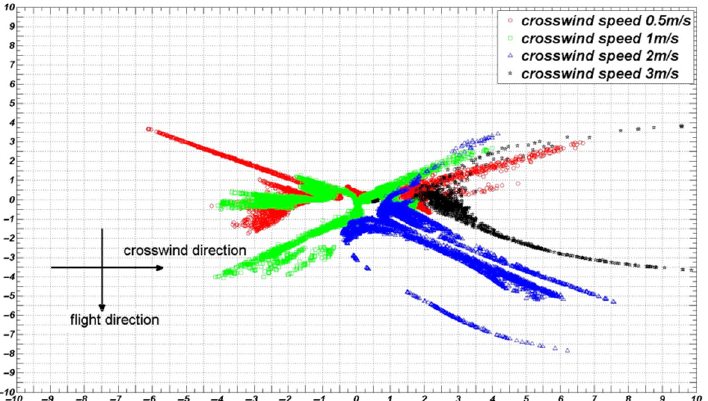
Figure 16. Droplet deposition situation at a flight height of 3 m, flight speed of 0 m/s, and different crosswind